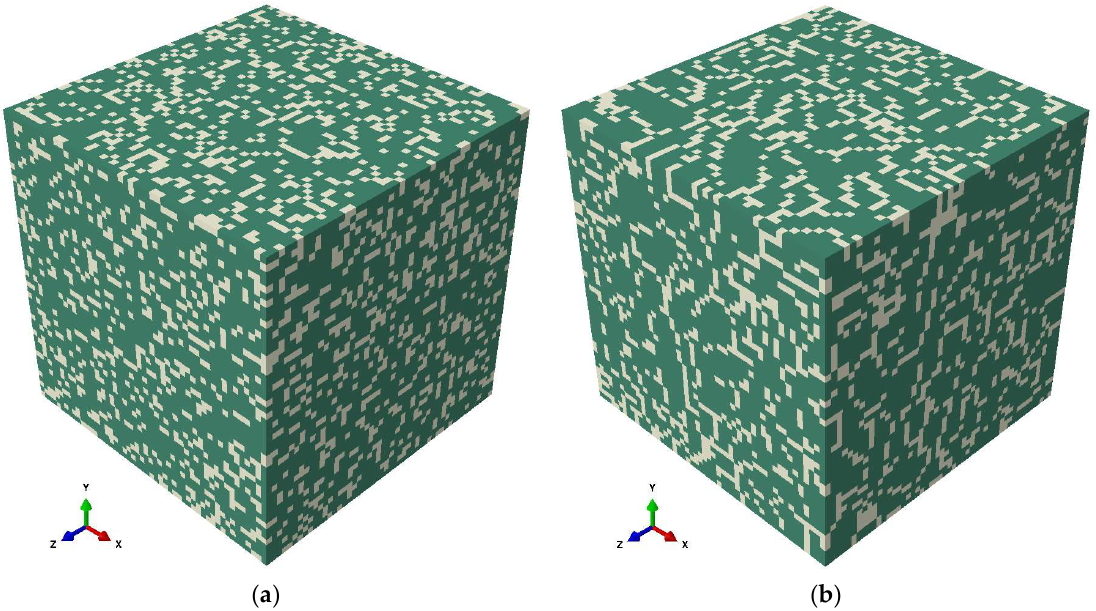
Figure 4. Three-dimensional synthetic RVEs generated from the experimentally determined SEM image, where the green region represents the Al matrix, and the yellow regions indicate regions of the Si-rich phase. ( a ) AB RVE with random Si-rich phase (random RVE), and ( b ) AB RVE with network-patterned Si-rich phase (network RVE).